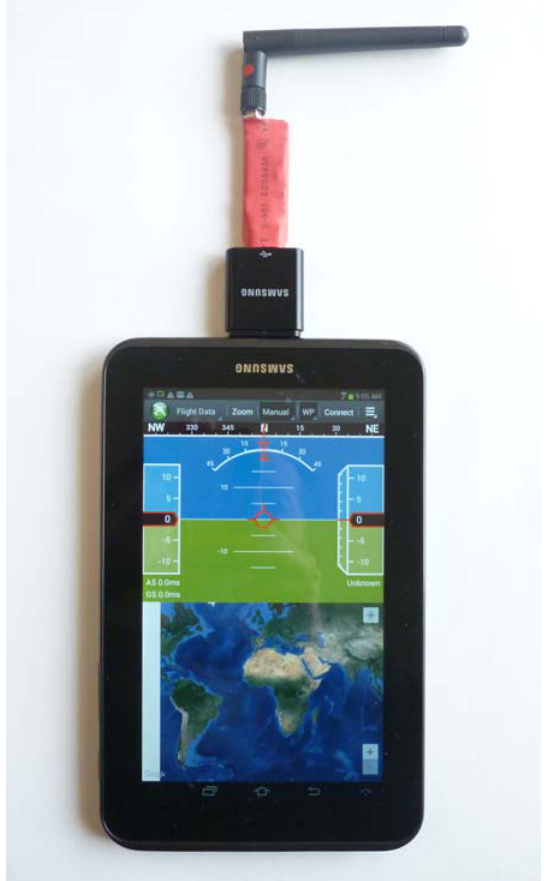
Figure 4. Ground Control System with 915MHz 3DR radio running Droidplanner Flight Planning